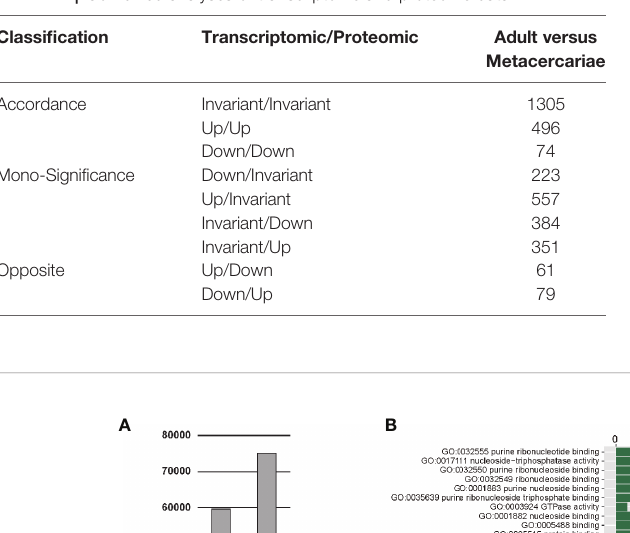
TABLE 2 | Combined analyses of transcriptome and proteome data.